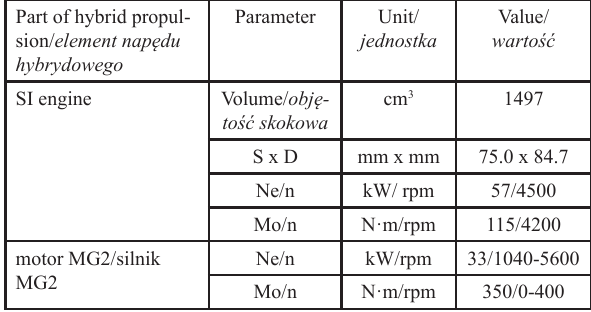
Table 2. Characteristics of the tested vehicle Tabela 2. Charakterystyka obiektu badawczego Part of hybrid propul - sion/ element napędu